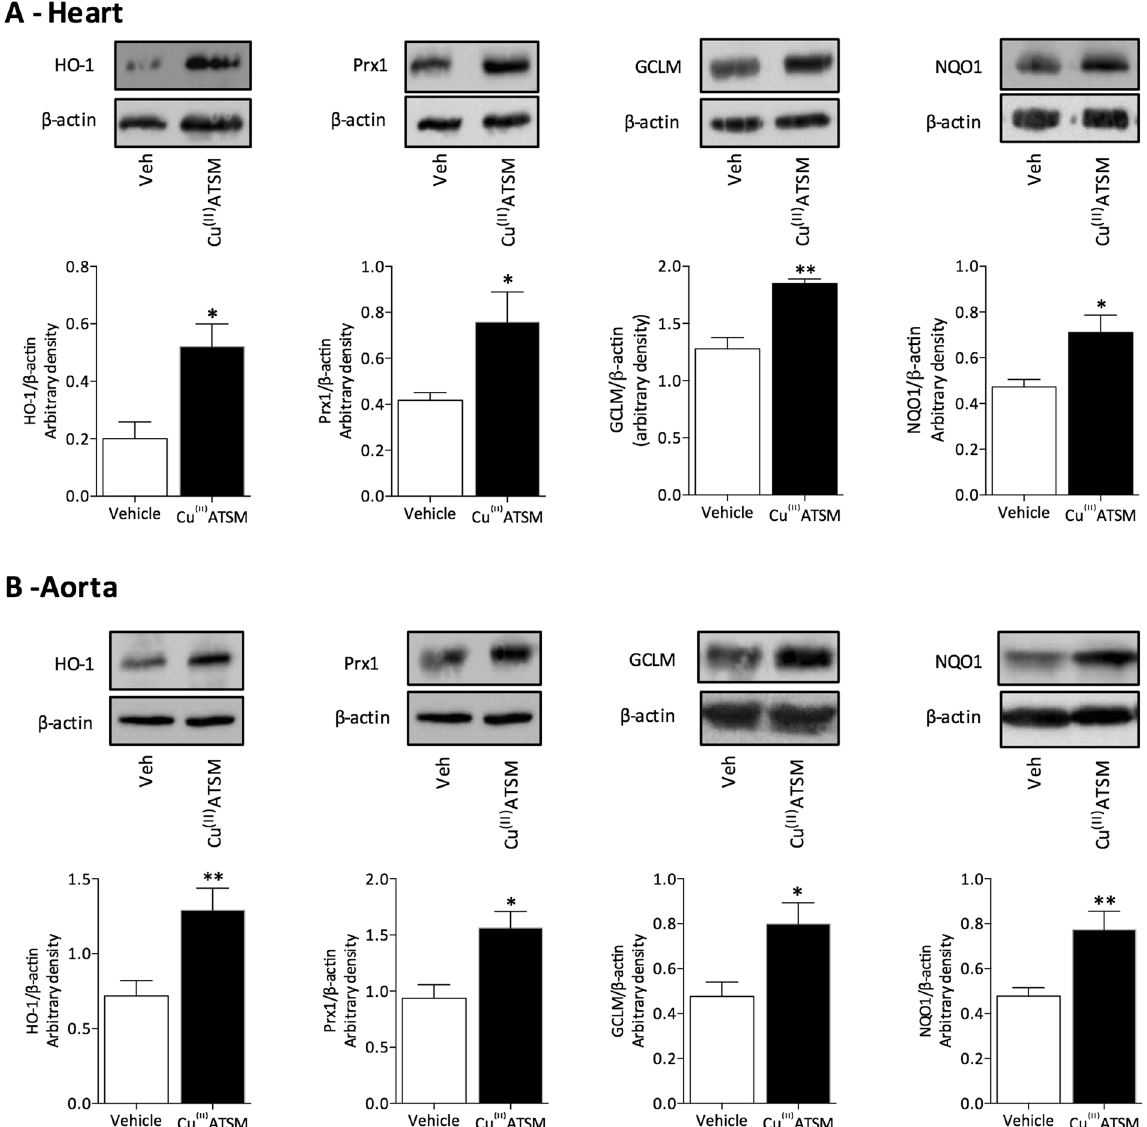
Figure 3. Oral delivery of Cu (II) ATSM induces Nrf2 target antioxidant protein expression in murine heart and aorta. Heart ( A ) and aortic ( B ) tissue homogenates from C57/BL6 male mice administered Cu (II) ATSM by oral gavage (30 mg/kg) were immunoblotted for HO-1, Prx1, GCLM and NQO1. Data denotes mean ± S.E.M., n = 5 animals per group, * P < 0.05 and ** P < 0.01 vs vehicle (Student’s